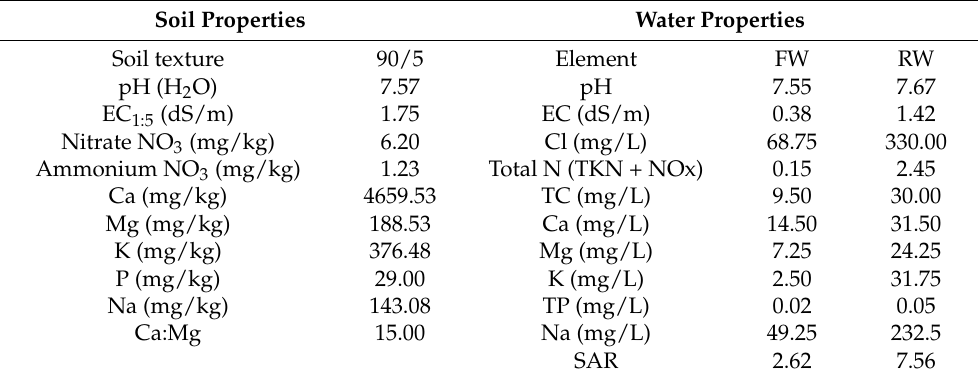
Table 1. Initial chemical and physical characteristics of the experimental soil and waters.